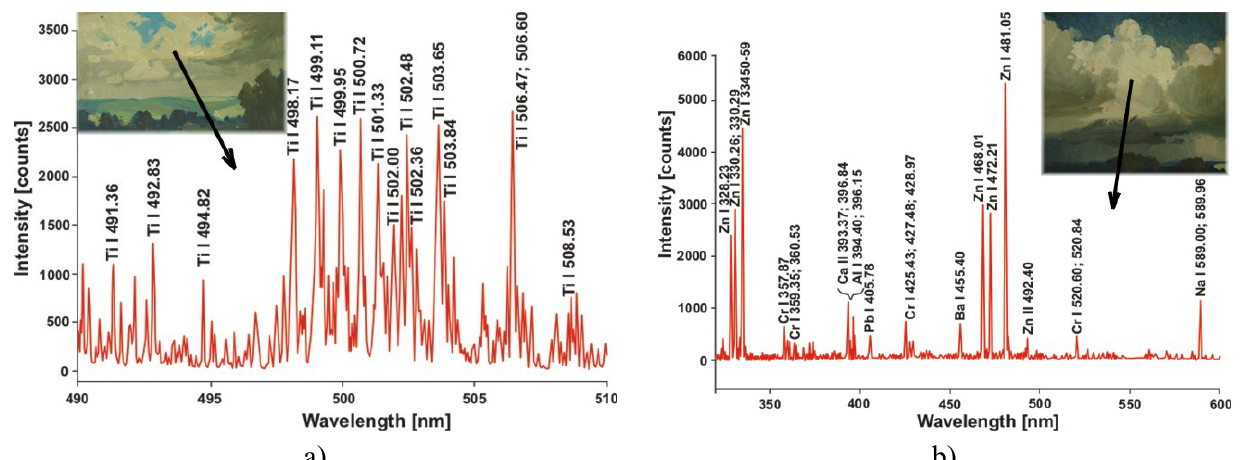
Figure 7. Stanis ł aw Ż ukowski landscape paintings - identification of white pigments: a) titanium white; b) zinc